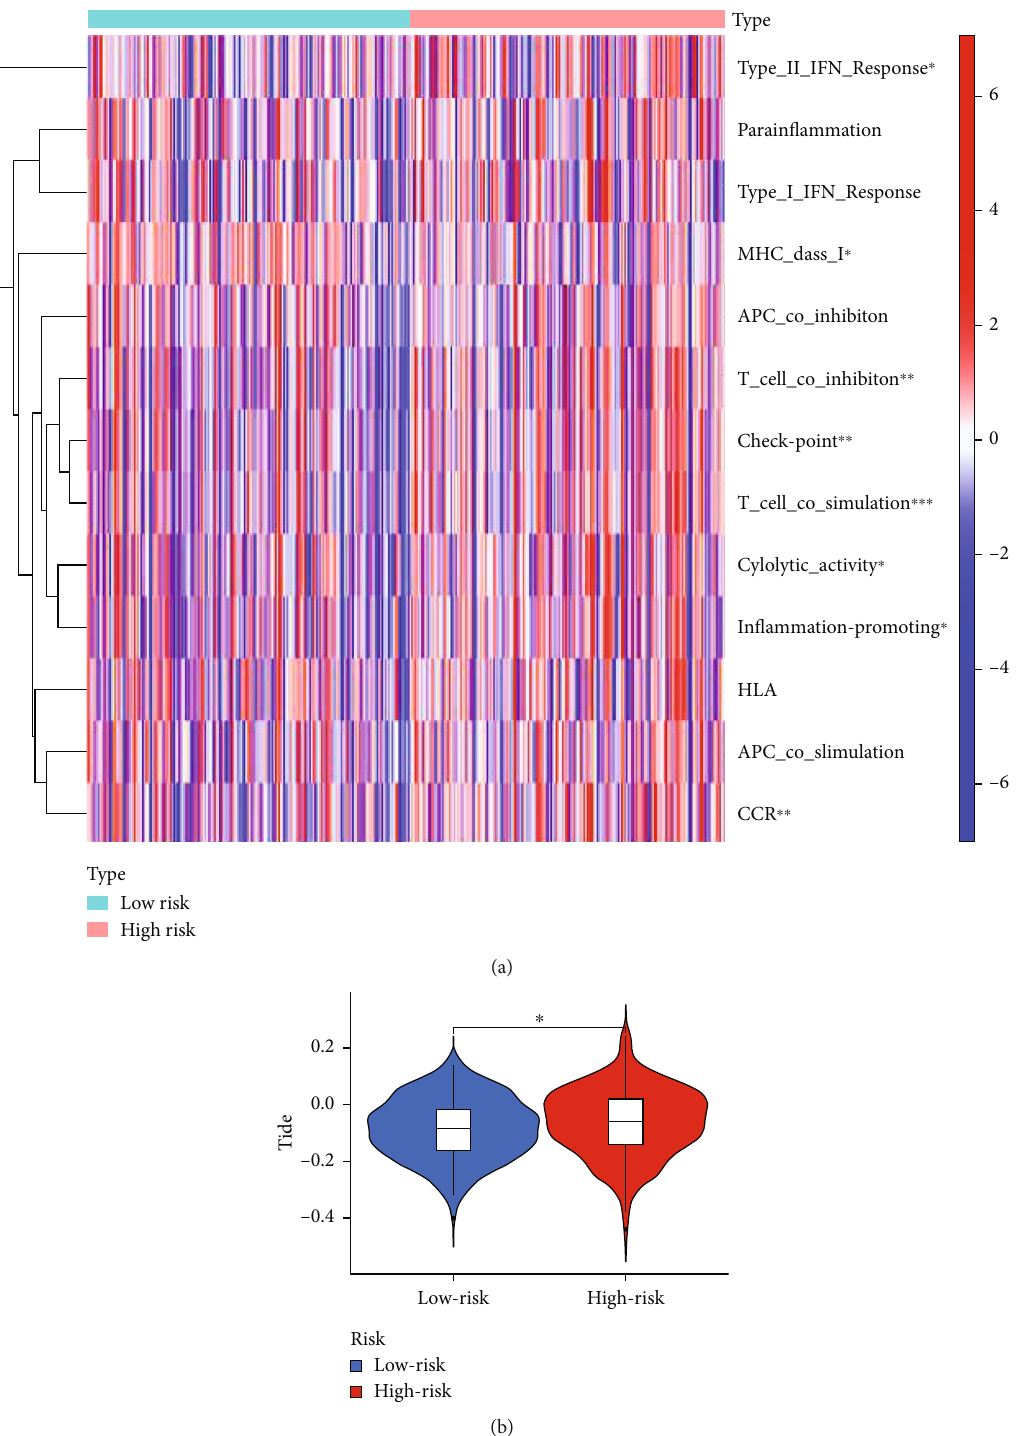
Figure 6: Analysis of immune function. (a) Heatmap analysis of immune-related functions. (b) Immune escape and immunotherapy of GC- related risk